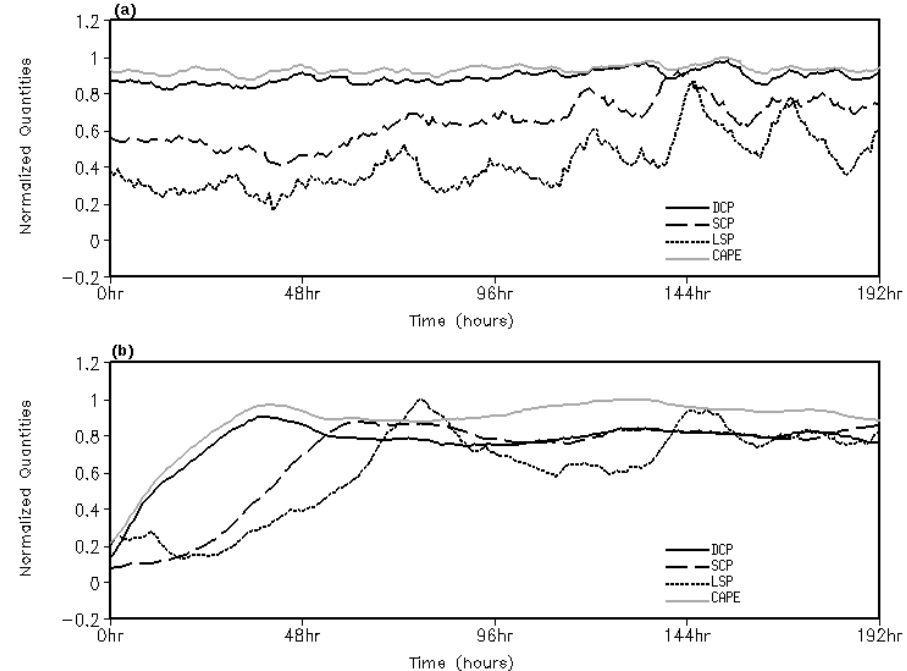
Fig. 16. Time evolution of area (12 ◦ S to 12 ◦ N and 0 ◦ E to 360 ◦ E) averaged quantities. Shown quantities are normalized against their maximum values. (a) TAU (1h), and (b) TAU (8h).